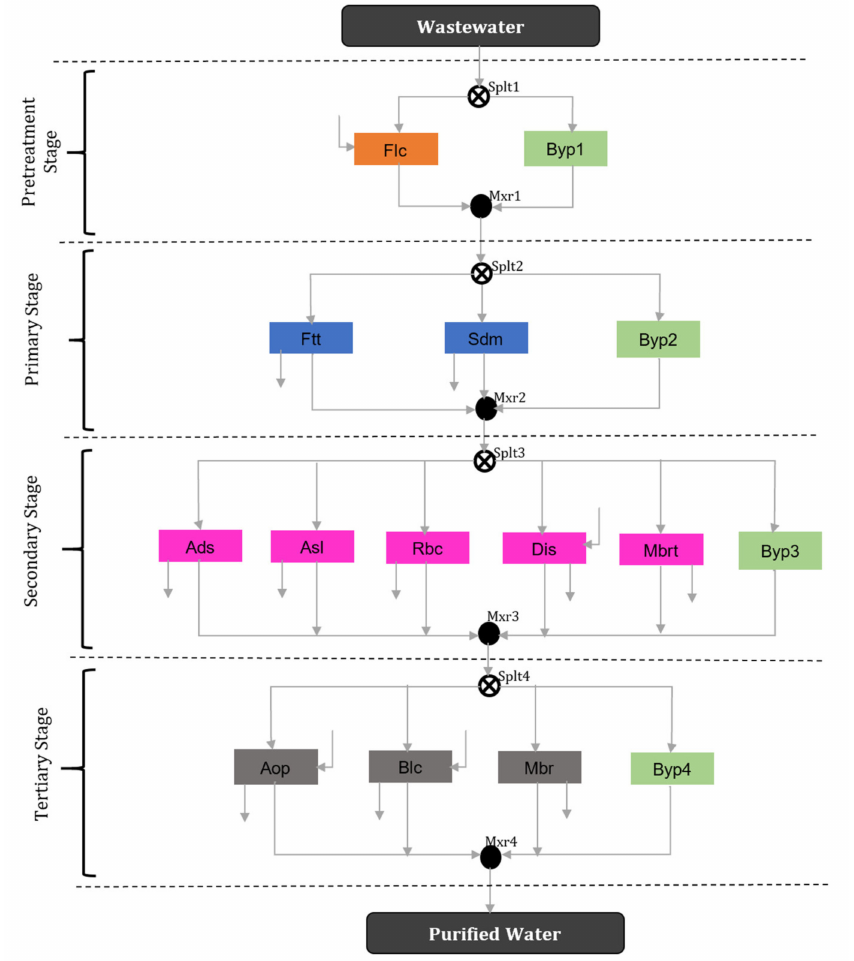
Figure 3. Overall superstructure for WW treatment. The treatment technologies are flocculation (Flc), sedimentation (Sdm), filtration (Ftt), adsorption (Ads), activated sludge (Asl), rotating biological containers (Rbc), disinfection (Dis), membrane bioreactor (Mbrt), advanced oxidation processes (Aop), bleaching (Blc), and membrane processes (Mbr). Bypass (Byp 1,2,3,4) streams become active if a stage does not apply to the treatment